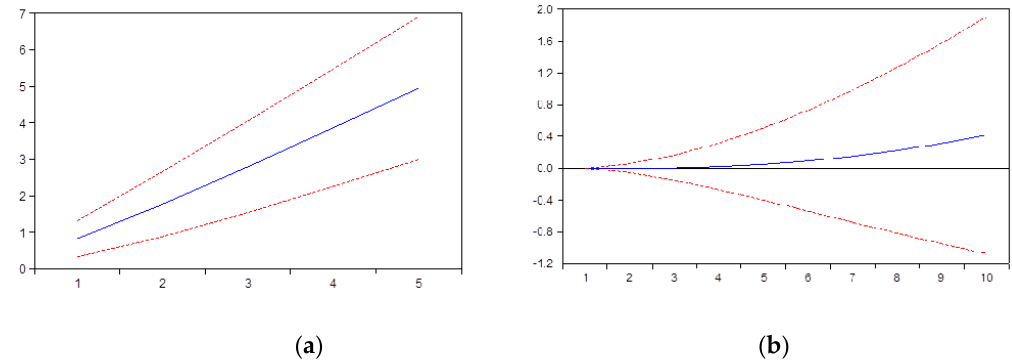
Figure 2. ( a ) Impact of Hi to IU; ( b ) Impact of Hi to PHH. Impact of internet usage and payments made by households for healthcare, expressed as euro per inhabitants.